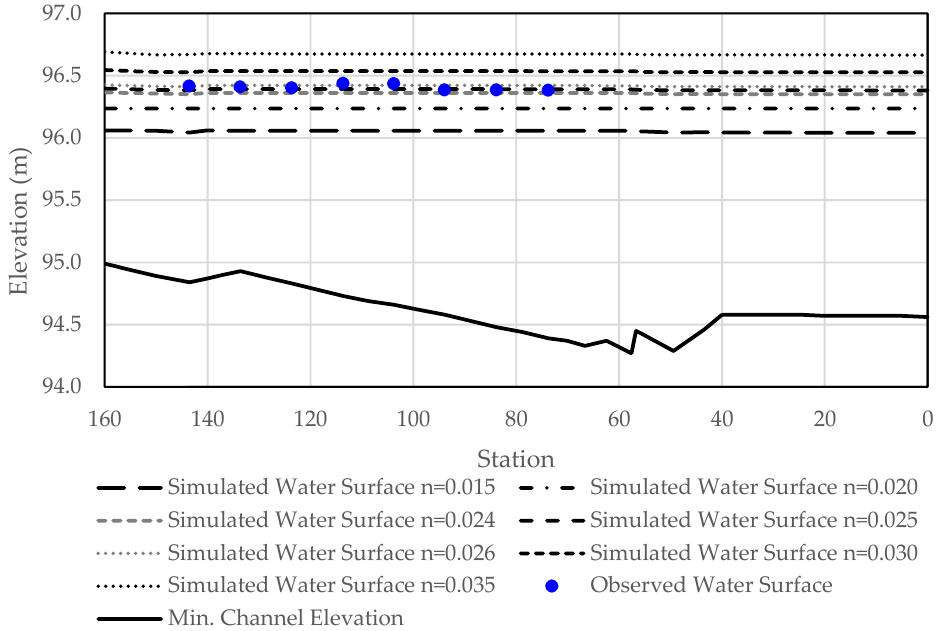
Figure 9. Comparison between the observed and simulated water surface with several Manning’s coefficient values (0.015, 0.020, 0.024, 0.025, 0.026, and 0.030) in order to calibrate the model. The upstream and downstream sections of the sand trap are on the right and left sides of the diagram, respectively. The black line curve denotes the channel bed elevation. A normal discharge of 2.03 m 3 /s obtained from the first measurement was utilized as an input for the steady flow data in this calibration process.